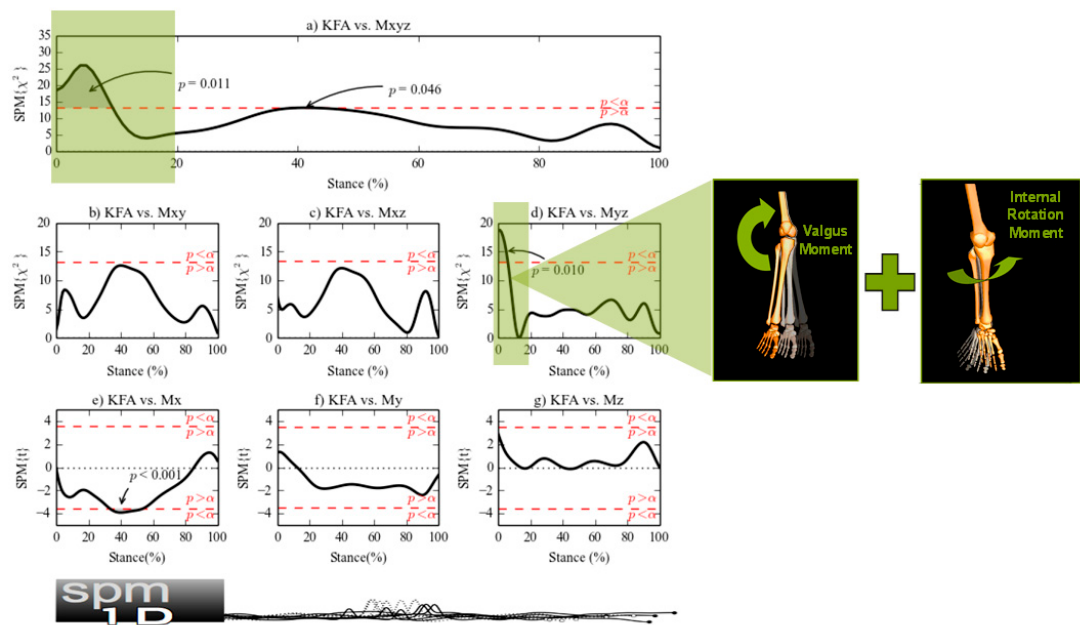
Figure 2. The top pane shows the relationship between knee flexion and three-dimensional knee moments (Mx,y,z). This relationship was primarily explained by combined frontal (valgus) and transverse plane (internal rotation) knee moments (middle), not the individual knee moment components (bottom).